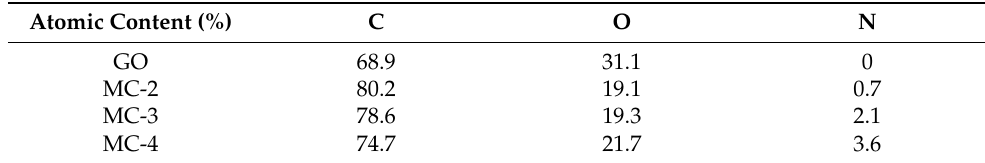
Table 2. The atomic content of the elements detected by XPS.